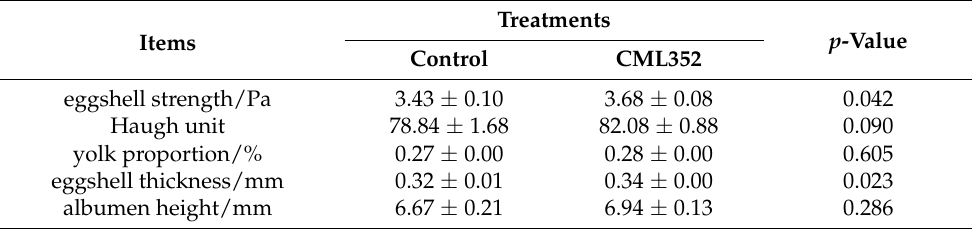
Table 10. Effects of dietary supplementation with L. salivarius on egg quality of laying